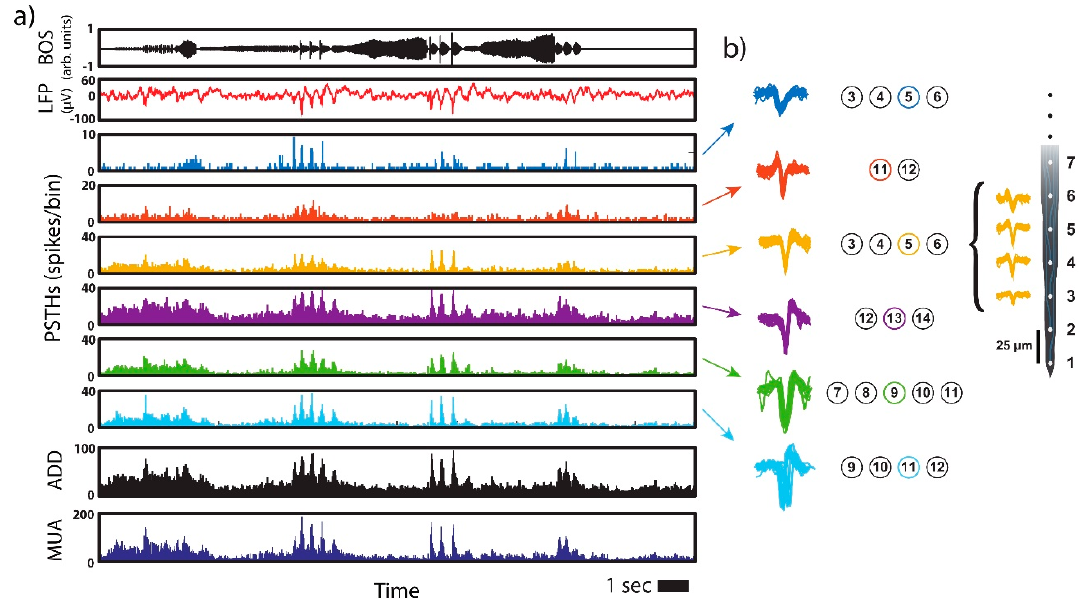
Figure 3. Single unit activity is synchronized in multiple recording sites. ( a ) Activity profiles of spike-sorted clusters from a recording. From top to bottom: BOS sound signal, trial- and channel- averaged LFP, PSTHs for each neuron and summed single unit activity (ADD). PSTHs are histograms (15 ms bins) of the activity elicited in each isolated neuron during 20 auditory presentations of the BOS. Lastly, the bottom panel shows the multiunit activity profile (MUA), obtained by thresholding the recorded neural data (see Section 3 and Figure 2). ( b ) Each action potential is recorded by several channels in the multielectrode array (a diagram is shown on the right). Spikes from individual, well-isolated neurons are shown with different colors. Spikes from the same neuron are simultaneously recorded as spikes of different shapes in different channels (see yellow cluster inset). The channels where each cluster was detected are shown to the right of each spike group. Color outlines indicate the maximum amplitude channel for each cluster, which corresponds with the spike shapes shown. Each cluster presents a robust response across trials (sharp peaks present in the PSTHs in ( a )). Additionally, these results show that registered neurons are synchronized. The sharp peaks in the ADD profile in ( a ) result from the combination of response robustness across trials and from the synchronous firing of isolated neurons.